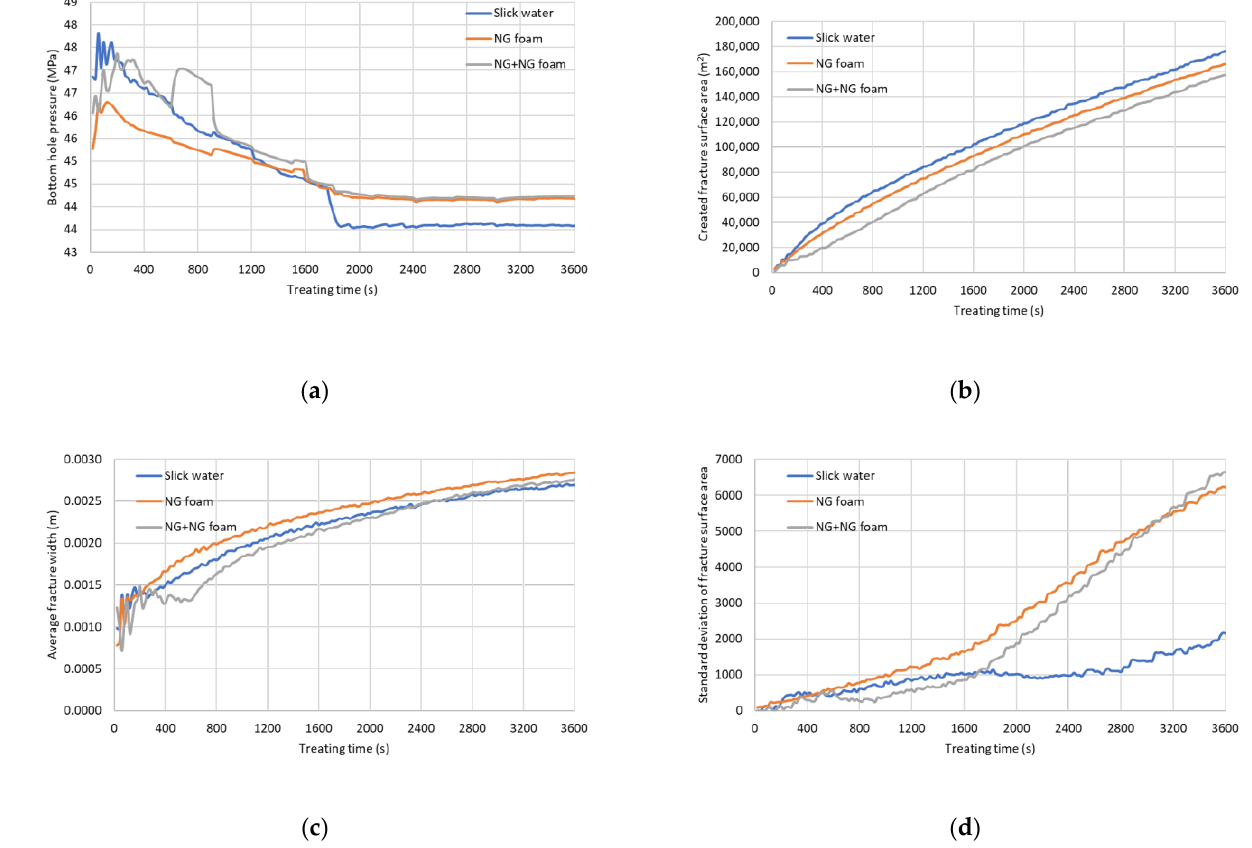
Figure 12. Fracture properties versus treating time plot. ( a ) Plot of bottom hole pressure versus treating time, ( b ) Plot of created fracture surface area versus treating time, ( c ) Plot of average fracture width versus treating time, ( d ) Plot of standard deviation of fracture surface area versus treating time.